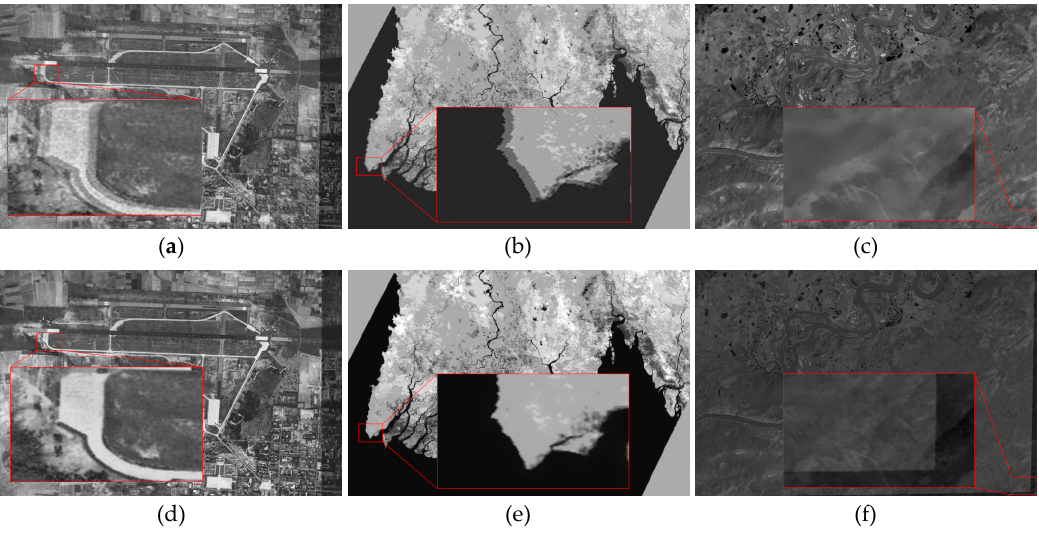
Figure 15. Registration results of three sample real image pairs. ( a ) Registration results of the UR-SIFT on the first image pair in the second group; ( b ) registration results of the RSISC on the fifth image pair in the second group; ( c ) registration results of the MSLD on the sixth image pair in the second group; ( d ) registration results of the RMLSM on the first image pair in the second group; ( e ) registration results of the RMLSM on the fifth image pair in the second group; ( f ) registration results of the RMLSM on the sixth image pair in the second group.